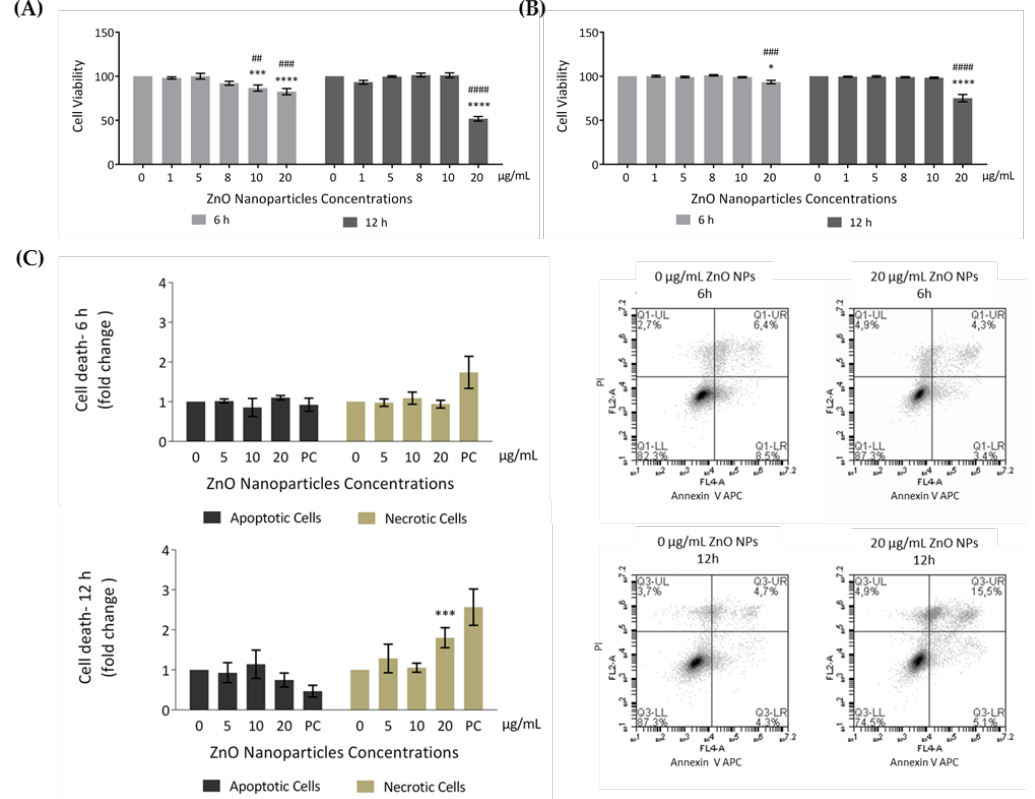
Figure 3. Evaluation of cell viability induced by ZnO NPs in GC-1 spg cells: ( A ) Cell viability was assessed using the resazurin assay. Results from the viability analysis of GC-1 cells after exposure for